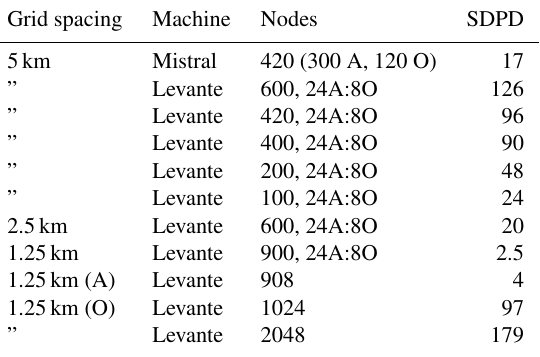
Table 1. Performance of global coupled configuration runs with a grid spacing of 5 and 2.5km, called G_AO_5km and G_AO_2.5km in Table 3 summarizing the setting of all simulations, and with a grid spacing of 1.25km. The performance at 1.25km is also given for an atmosphere-only (A) and ocean-only (O) configuration as the throughput of the coupled simulation has not been fully optimized yet. Under nodes, “A” stands for atmosphere and “O” for ocean. On Levante, the A and O numbers give the load balancing, and on Mistral they directly give the number of processors. The specifi- cations of Mistral and Levante nodes are as follows. Mistral node: 2x 18-core Intel Xeon E5-2695 v4 (Broadwell) 2.1GHz, connected